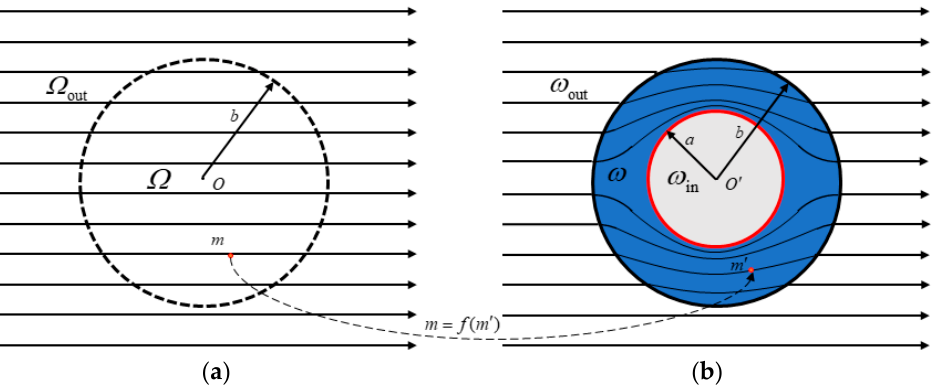
Figure 1. Acoustic transformation theory: ( a ) the original space acoustic propagation; ( b ) the transform space acoustic propagation. form space acoustic